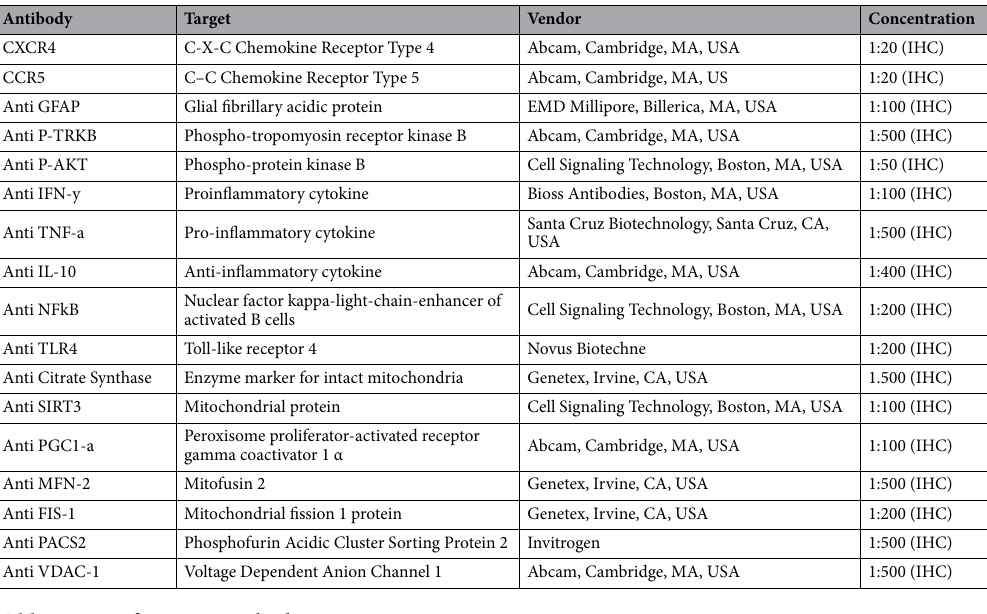
Table 1. List of primary